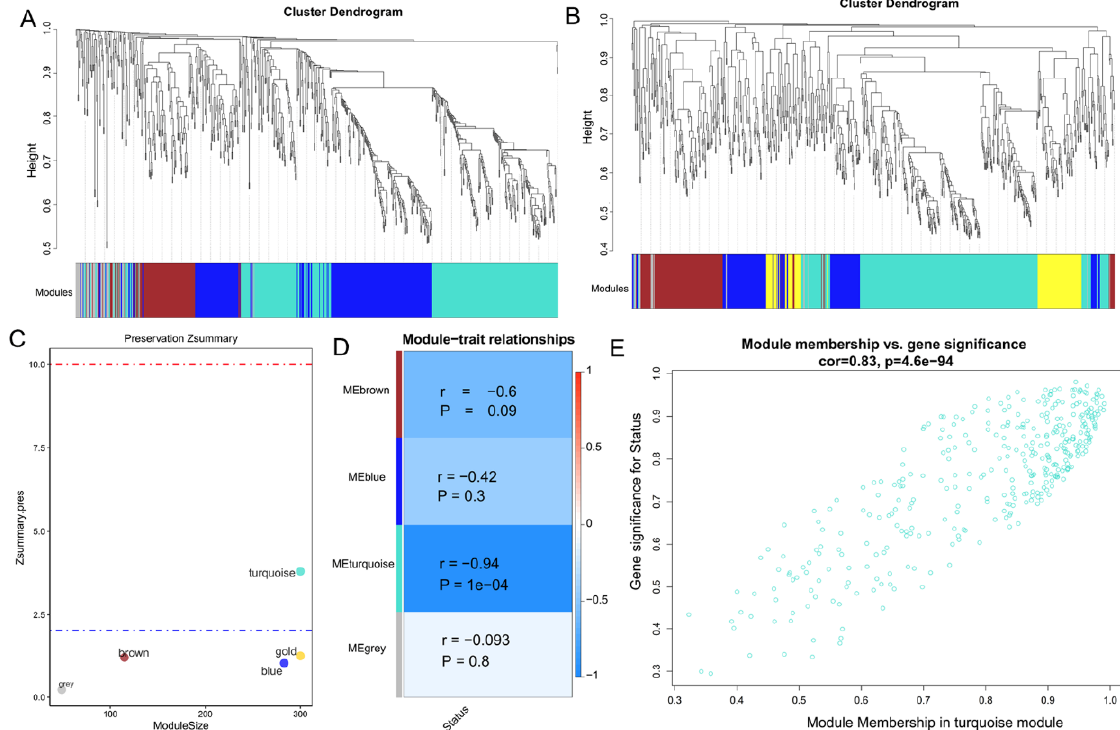
Figure 2. Identification of modules associated with CNT-induced malignant transformation of lung cells. ( A ) A clustering dendrogram obtained from data of the GSE41178 dataset; ( B ) a clustering dendrogram obtained from data of the GSE56104 dataset; ( C ) the preservation median rank of co-expression modules; ( D ): module–trait associations. Each row corresponds to a module eigengene (ME) and each column to a trait. Each cell contains the corresponding correlation (r) and p -value; ( E ) scatter plot showing the correlation of gene significance versus module membership for genes in the turquoise module.